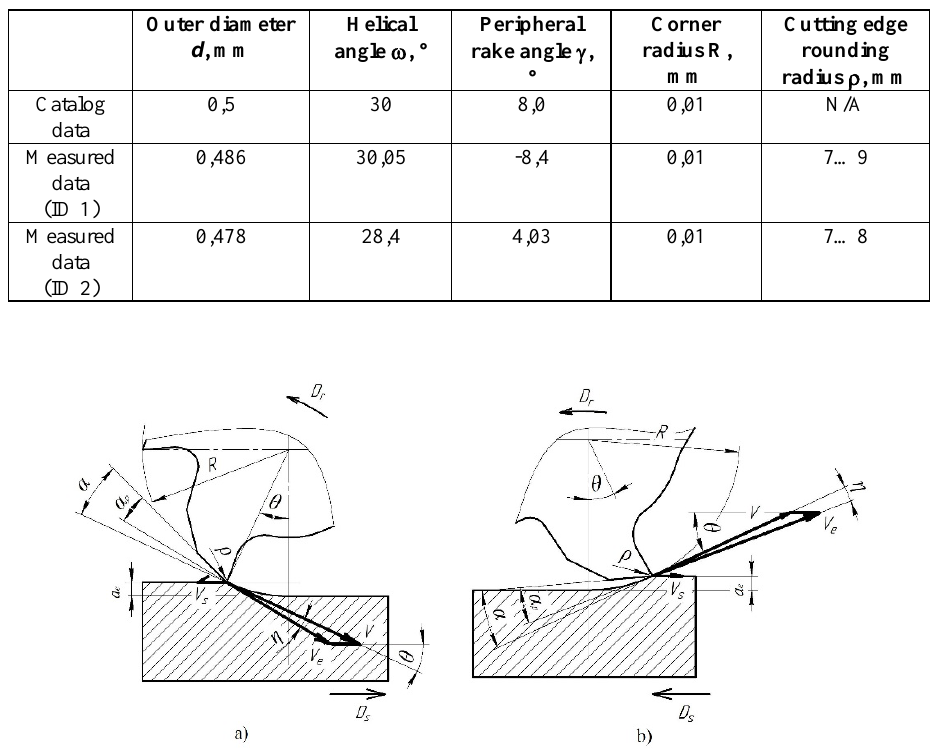
Fig. 3. Schemes of milling for determination the angles η and α р , a – in down milling, b – in up-milling, V – the velocity of the main cutting movement at the considered cutting point; V e – the velocity of the resulting cutting speed; V s – the velocity of the feed; η – the cutting speed angle; θ 1 , θ 2 – the angles of contact of cutting tooth with the workpiece surface at the engagement and at some instance, respectively; a e – the radial depth of cut; α р – the kinematic clearance angle in the working plane; α – the clearance angle, ρ – the cutting edge rounding radius, D s – the feed velocity, D r – the main cutting movement